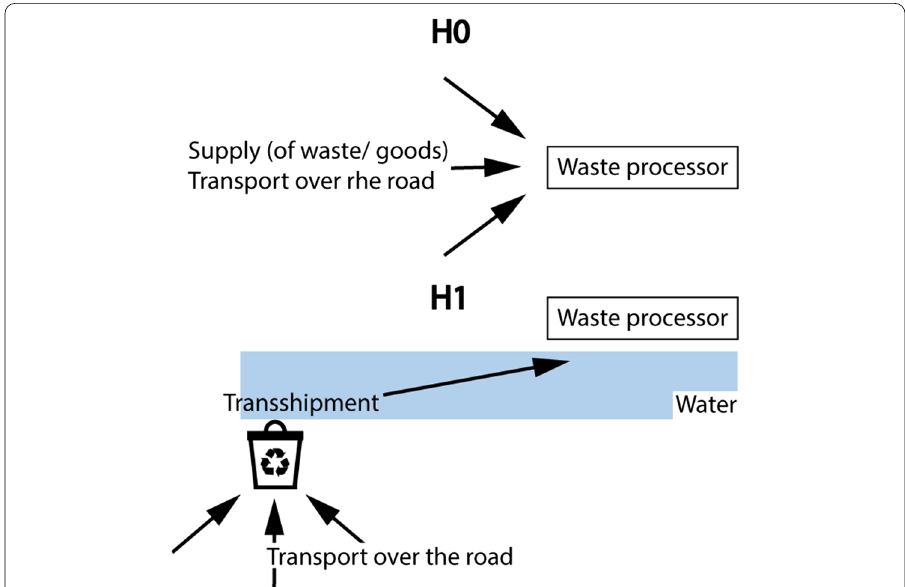
Fig. 8 Representation of transport over water. Source: Own